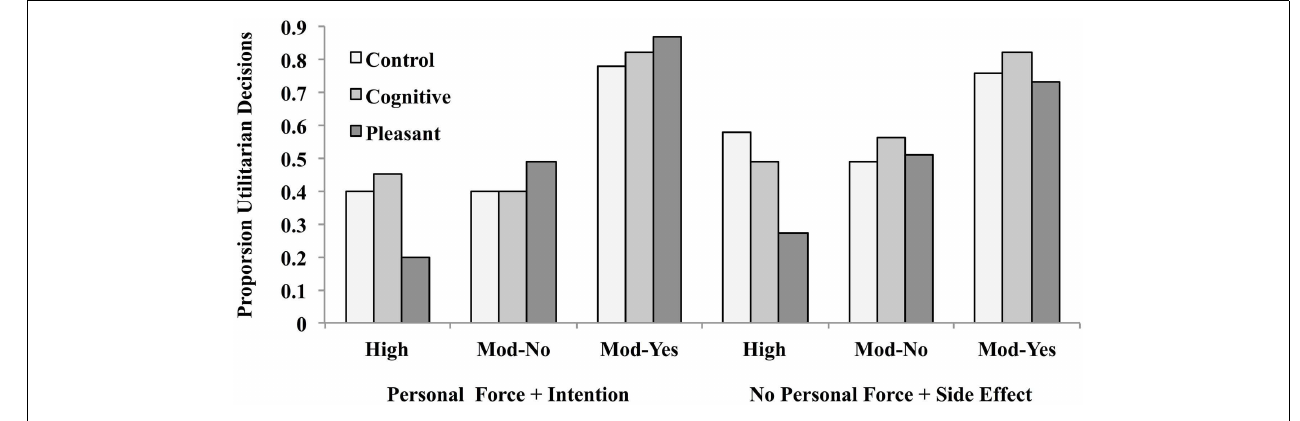
FIGURE 8 | Proportion utilitarian judgments following an emotion rating task involving pleasant stimuli, a cognitive task requiring mental arithmetic, and a control group that involved neither in Experiment